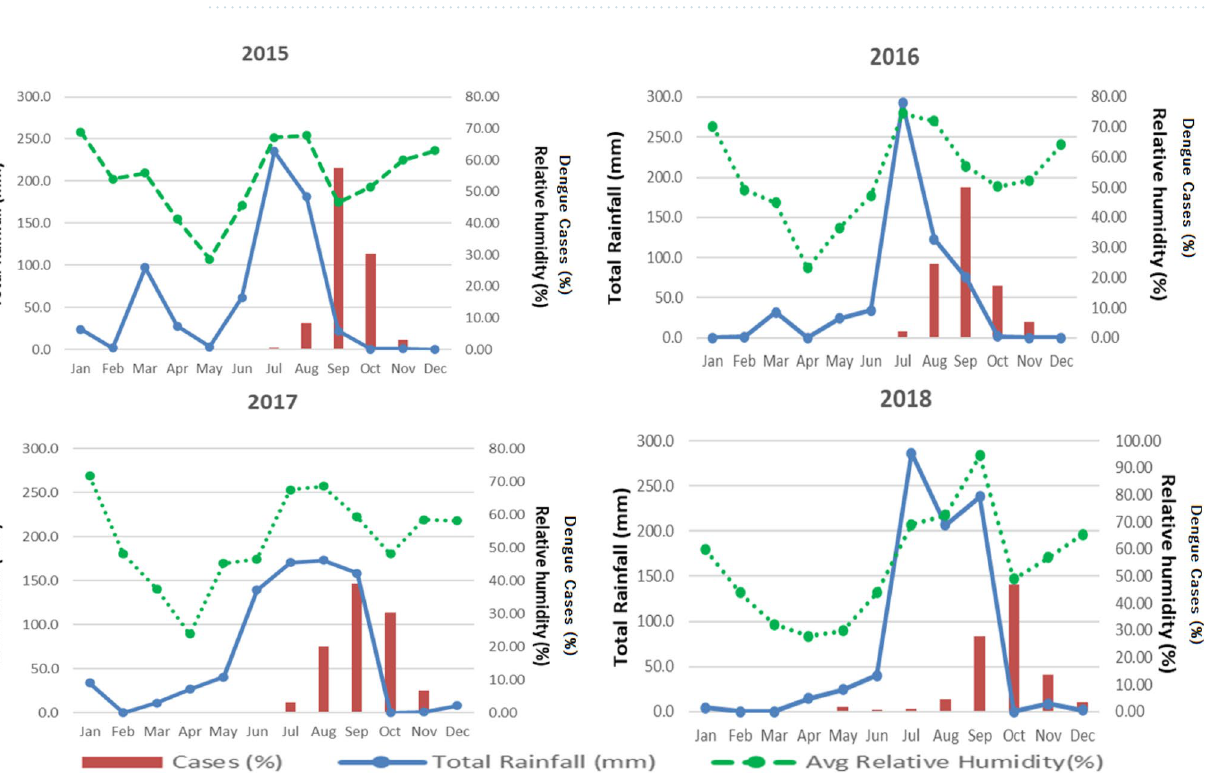
Figure 2. Monthly occurrences of dengue cases and average total rainfall with humidity, 2015–18, Delhi,